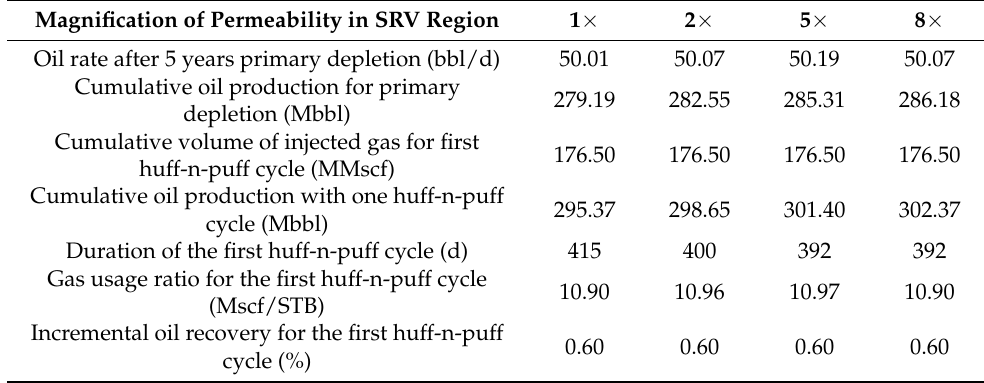
Table 16. Summary of results for huff-n-puff with different permeability magnifications in the SRV region.